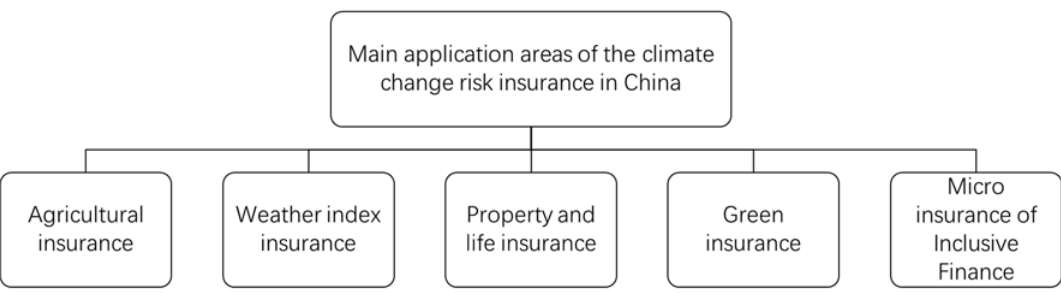
Figure 4. Main application areas of climate change risk insurance in China.